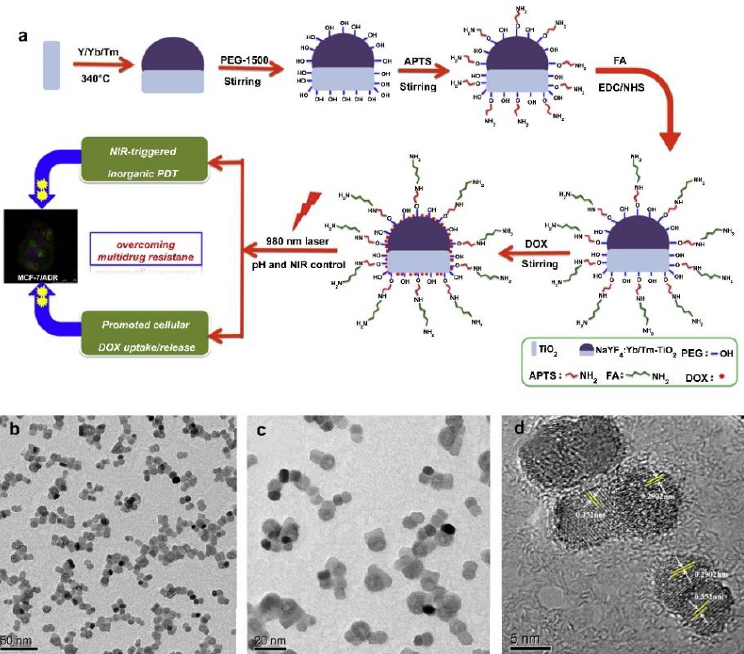
Figure 9. ( a ) Synthesis of DOX-loaded, FA-targeted NaYF4:Yb/TmeTiO 2 nanocomposites for NIR-triggered PDT and chemotherapy in resistant breast cancer, ( b – d ) TEM and HRTEM images of NaYF4:Yb/TmeTiO 2 nanocomposites. Re- printed with permission from reference [147] . Copyright 2015